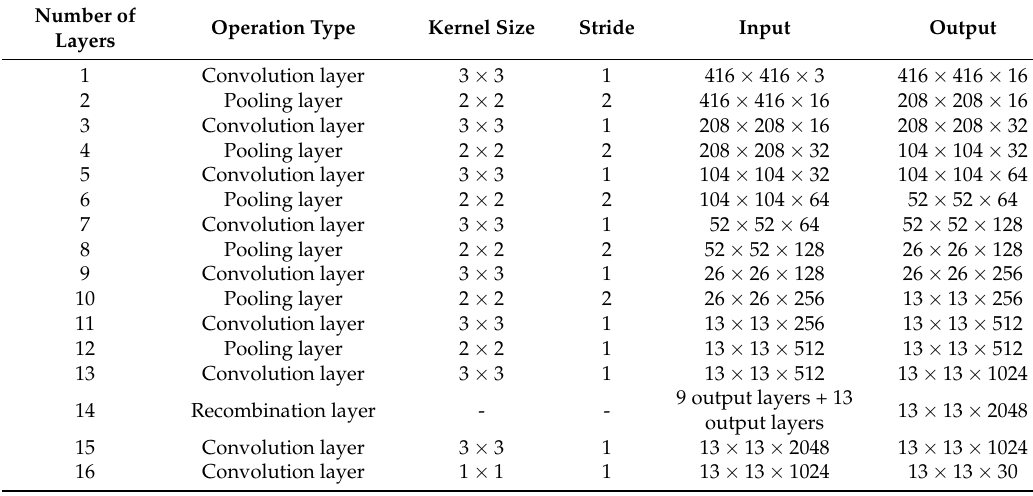
Figure 4. Structure of identification model network of precision parts. Table 1. Parameter settings of the identification model network of precision parts.